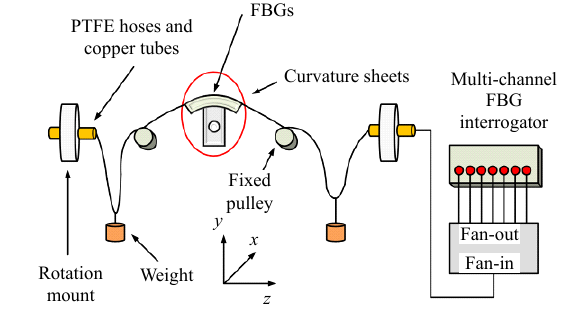
Fig. 5 Experimental setup for 2D curvature measurement.